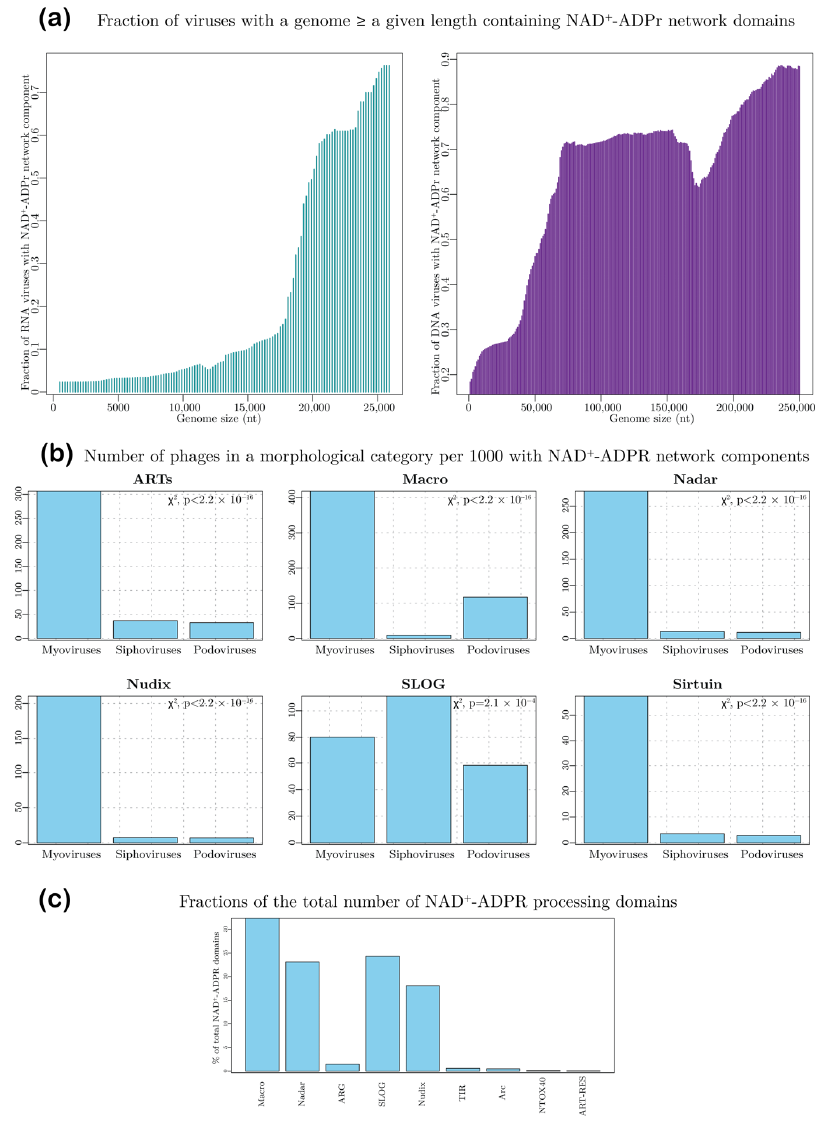
Figure 2. Distribution of NAD + –ADPr network domains in the virus world. ( a ) Fraction of RNA (left) and DNA (right) viruses with a genome ≥ a given length containing NAD + –ADPr network domains. ( b ) Distribution of various NAD + -ADPR domains in the Myoviruses, Siphoviruses and Podoviruses. The graphs depict the number of phages per 1000 containing the given domain in that morphological category. ( c ) Prevalence of various NAD + –ADPr processing domains depicted as a percentage of the total